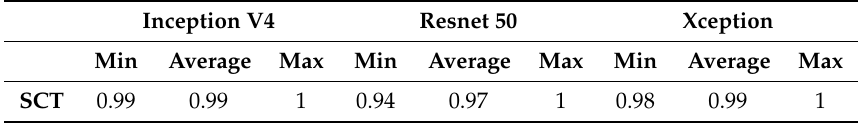
Table 4. E ff ect of the number of images per partition on the SCT of each CNN